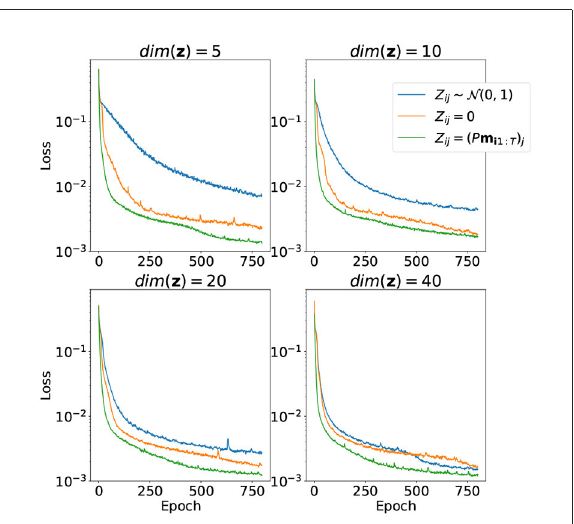
FIGURE4 Convergence of the loss function over 800 training epochs for different ways to initialize matrix Z and different dimensions of z. Both model parameters θ and matrix Z are